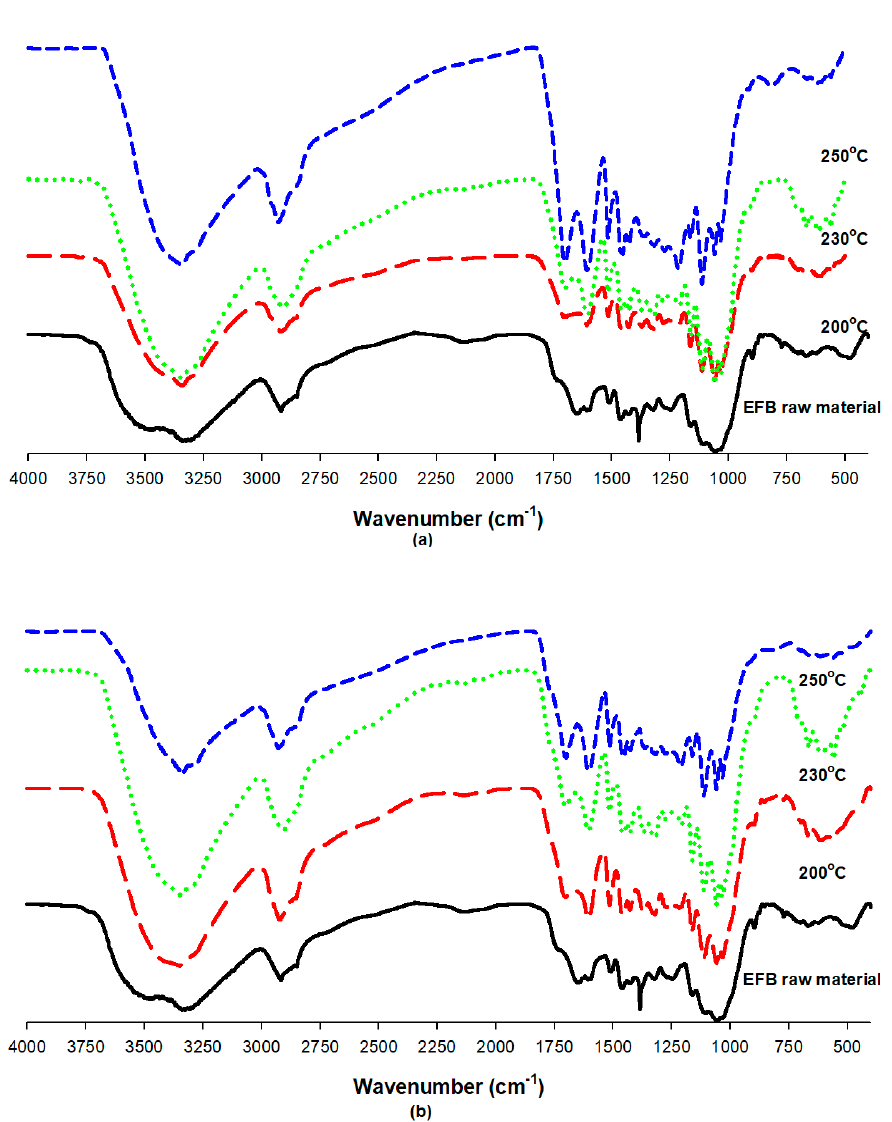
Figure 9. Fourier transform infrared spectroscopy (FT-IR) spectra of EFB according to the reaction temperature and water content: ( a ) EFB:water = 1:8; ( b ) EFB:water = 1:16. temperature and water content: ( a ) EFB:water = 1:8; ( b ) EFB:water =